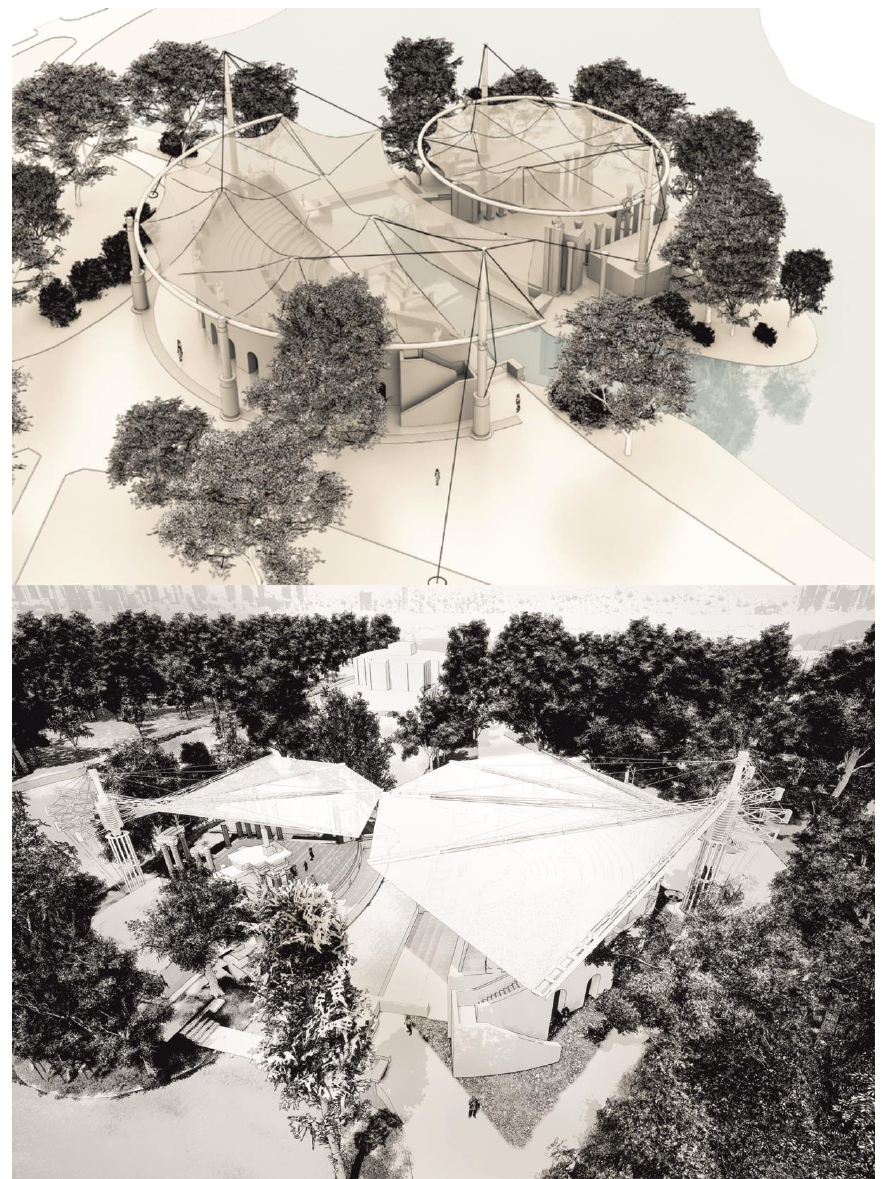
Figure 14. Competition entry team DiM’84 second prize. A first prize was not awarded. Reprinted from ref. [22]. Competition entry BP Projekt mention. Reprinted from ref.